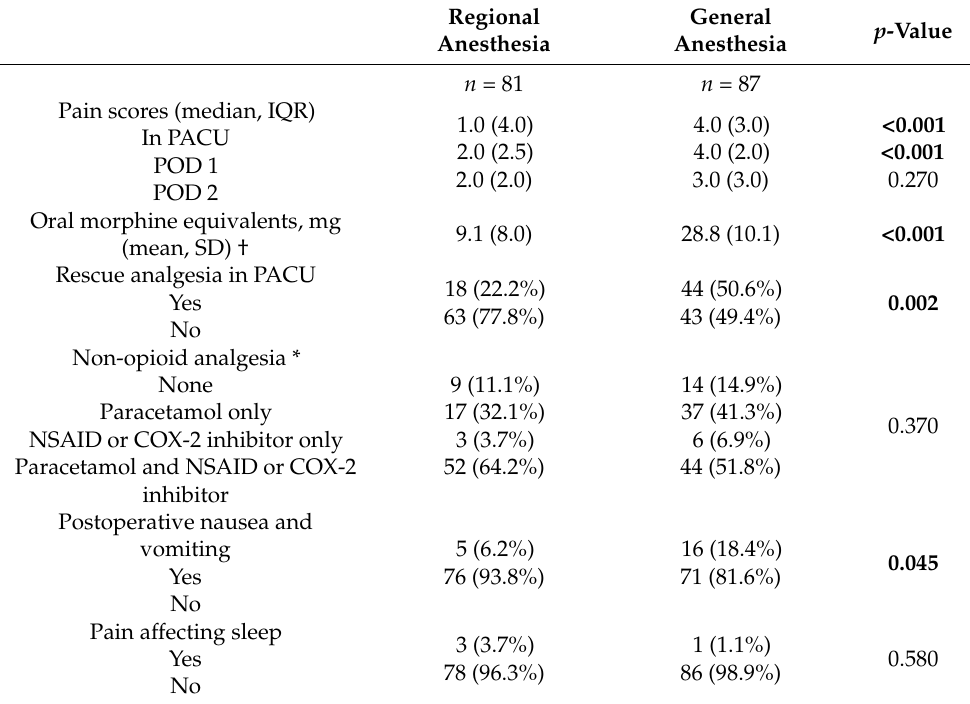
Table 2. Pain scores and opioid requirements of patients who received a regional anesthetic technique versus those who received general anesthesia